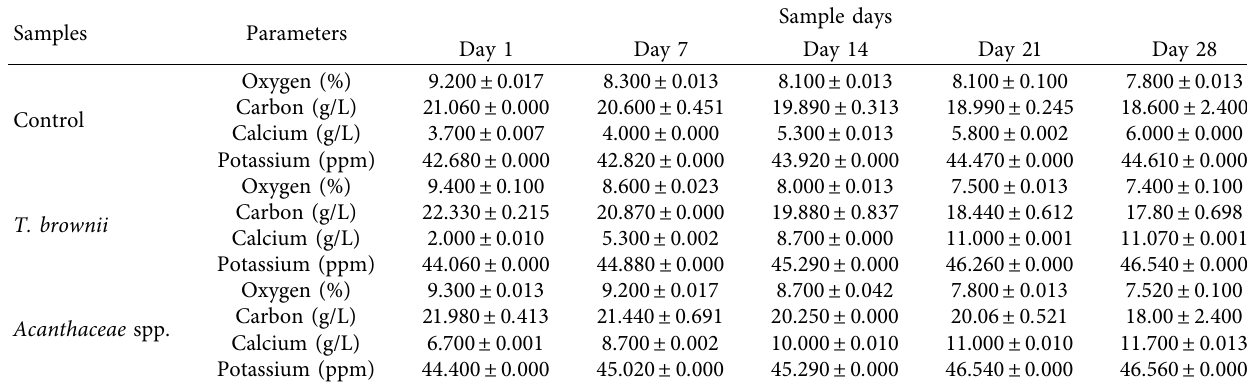
Table 5: Variation in oxygen, carbon, calcium, and potassium in bioslurry.